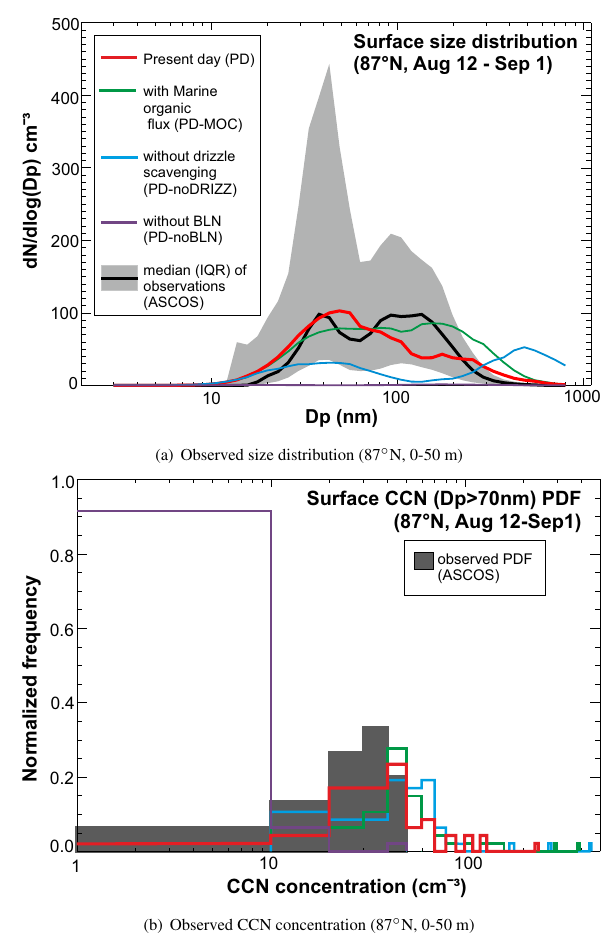
Fig. 3. Model evaluation of high-latitude (87 ◦ N) aerosol against observations from the 2008 ASCOS campaign. Fig (a) shows the median (and interquartile) size distribution observed during the ASCOS ice-drift period (Aug 12-Sep 1) compared to; (red) a present day (2008) model run [PD], (purple) a model run without boundary layer nucleation [PD-noBLN], (blue) a model run without stratocumulus (drizzle) scavenging [PD-noDRIZZ] and (green) a model run including our derived marine organic carbon flux [PD-MOC]. For each run, the modelled size distribution was calculated over the diameter range 3 - 800nm to match the size limitations of the DMPS instrument. Fig (b) shows the probability density function (PDF) of CCN concentration per cm − 3 observed during the ASCOS ice-drift period (grey), and derived from daily resolved CCN concentrations from all four model runs described.